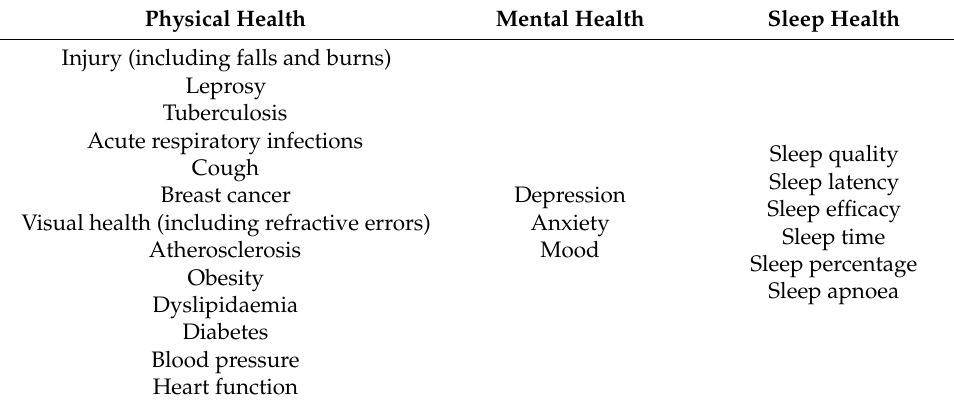
Table 2. Specific health outcomes in the broad health domains. Physical